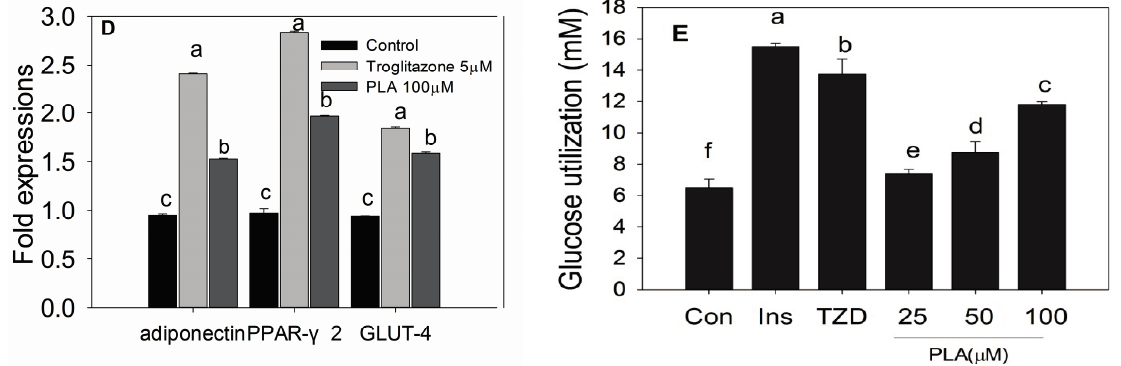
Figure 6. Effect of troglitazone and PLA on lipid accumulation and glucose utilization. ( A ) Lipid accumulation in control; ( B ) Lipid accumulation in troglitazone-treated cells (5 μ M); ( C ) Lipid accumulation in the PLA-treated cell (100 μ M); ( D ) adipocyte treated with troglitazone (5 μ M) and PLA (100 μ M) increased adiponectin, PPAR- γ 2 and GLUT-4 expression in adipocytes; ( E ) Glucose utilization in 3T3-L1 cells by troglitazone (TZD), Ins- insulin, and different concentration of PLA. Data were shown as means ± SEM of six replicates. Different letters a, b, c, d, e, f within treatments indicate significant differences ( p <